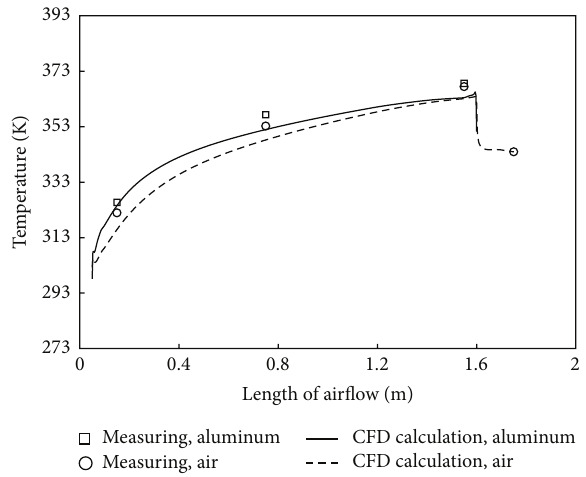
Figure 9: Temperature comparison between measurement and = 2 m/s. CFD calculation at V in